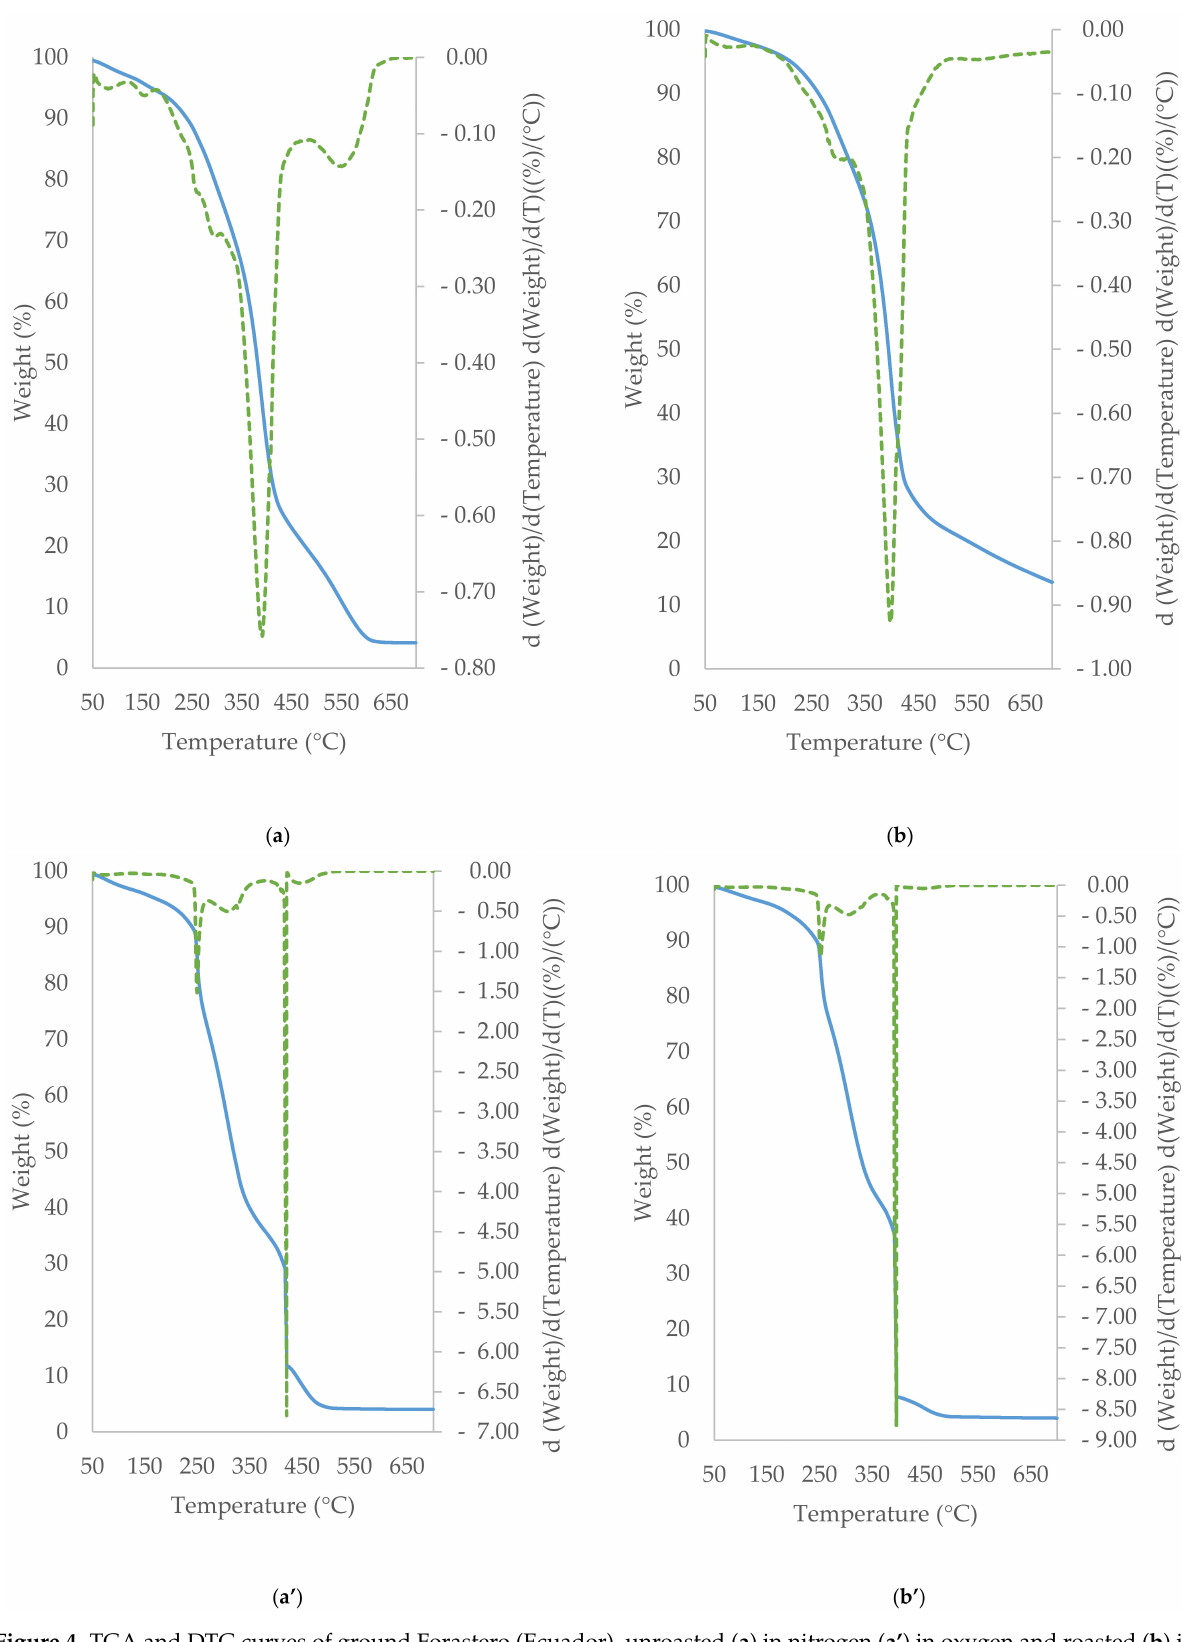
Figure 4. TGA and DTG curves of ground Forastero (Ecuador), unroasted ( a ) in nitrogen ( a’ ) in oxygen and roasted ( b ) in nitrogen and ( b’ ) in